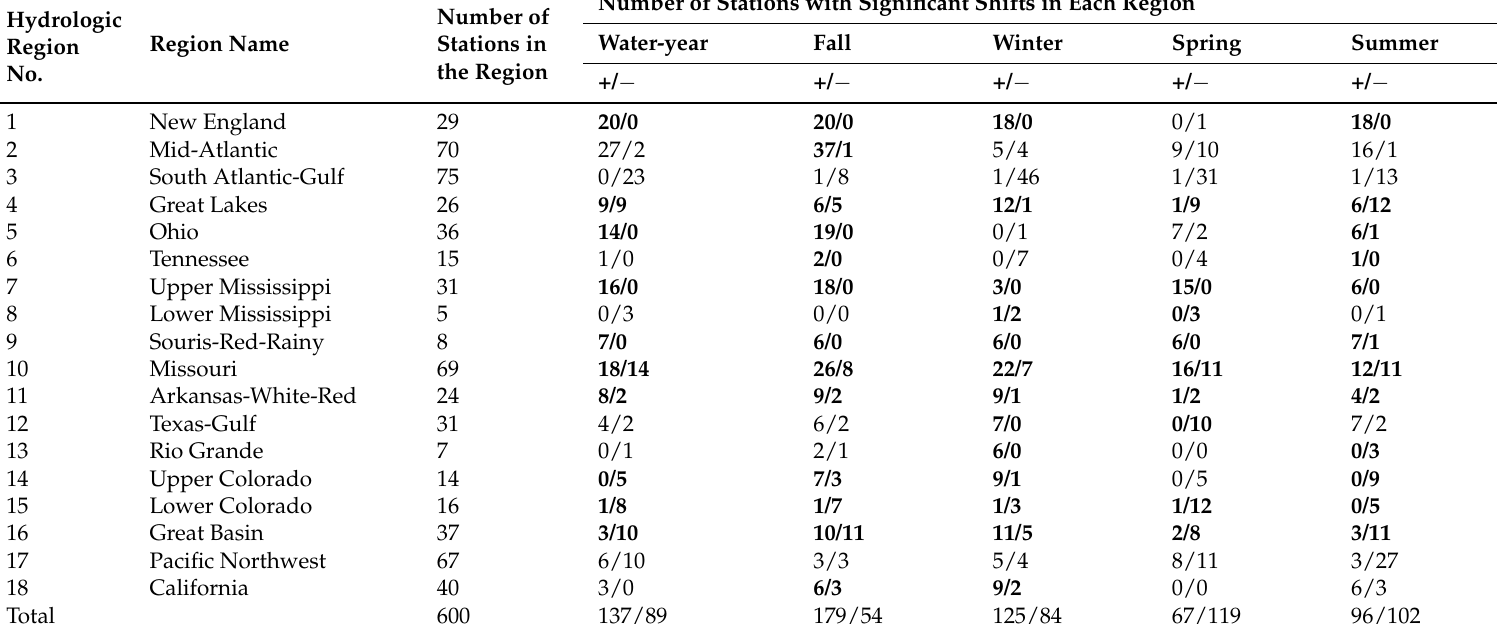
Table 2. Results of the Pettitt’s test at each hydrologic region for water year and the four